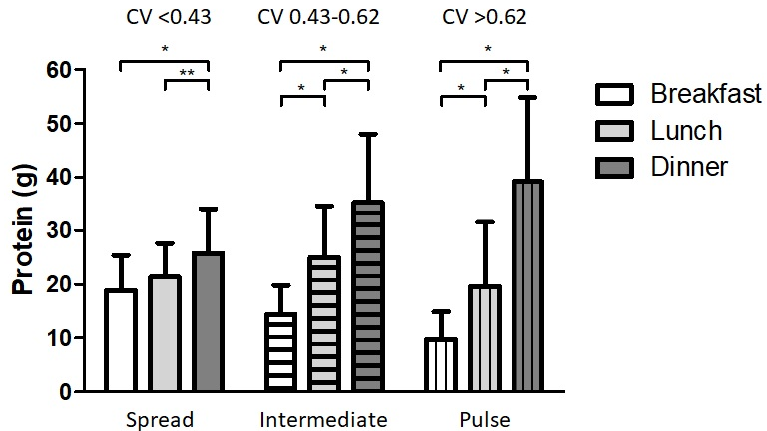
Figure 1. Protein intake during main meals of the participants in tertiles based on CV (coefficient of variance). Participants in the spread group ( n = 46, CV < 0.43) had a significantly higher protein intake at dinner compared to the protein intake at breakfast and lunch. Participants in the intermediate group ( n = 48, CV 0.43–0.62) and participants in the pulse group ( n = 46, CV > 0.62) had significant different intakes at all main meals. * p < 0.001, ** p = 0.011. Data are presented as means ± SDs.